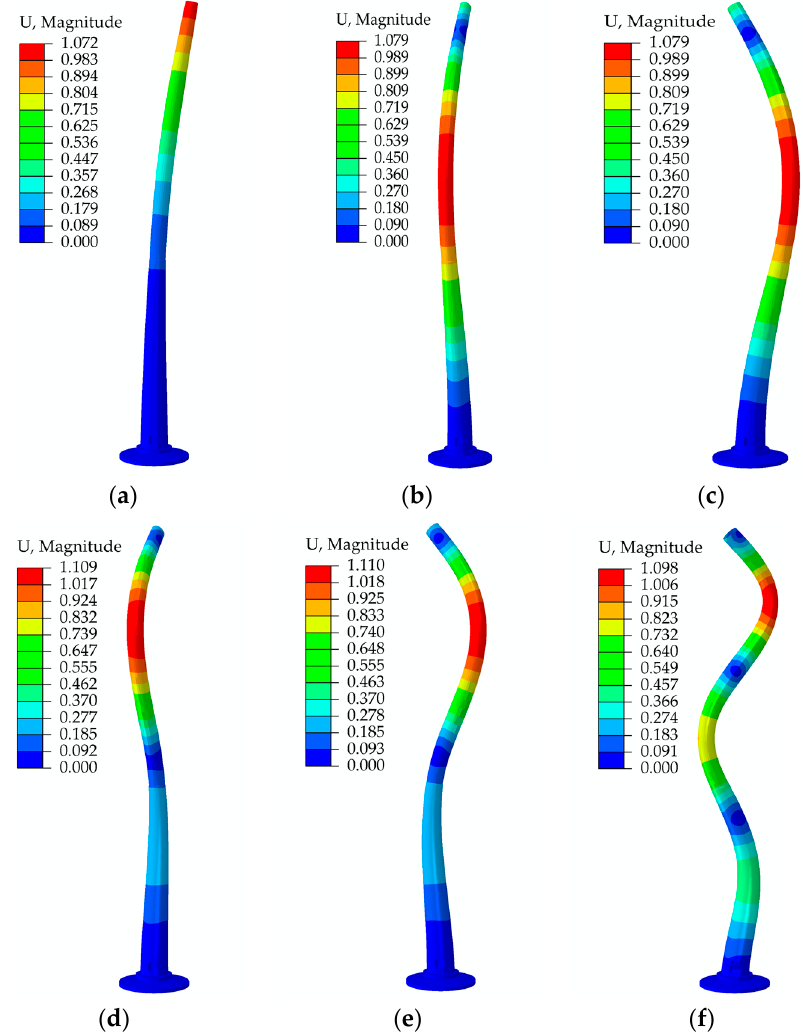
Figure 7. First six order modes of the tower without TMD: ( a ) first order mode; ( b ) second order mode; ( c ) third order mode; ( d ) fourth order mode; ( e ) fifth order mode; ( f ) sixth order mode. Table 2. Parameters of TMD.